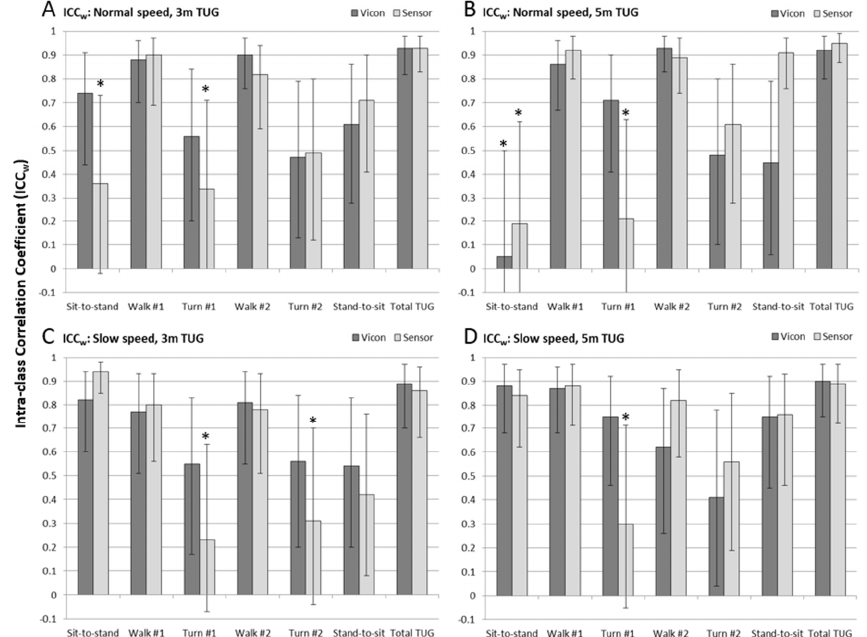
Figure 6. Intraclass correlation within measures (ICC w ) showing the level of repeatability of sensor (light gray) and Vicon (dark gray) measurements of sub-task performance, for each of the four experimental conditions: ( A ) 3 m normal speed; ( B ) 5 m normal speed; ( C ) 3 m slow speed, and; ( D ) 5 m slow speed. Whiskers represent the 95% confidence intervals on the ICC and the asterisk indicates sub-tasks where the 95% confidence interval enclosed zero, and was therefore non-significant (p > 0.05).